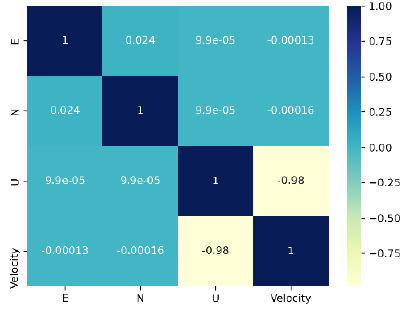
Figure 4 . Parameter correlation of cross